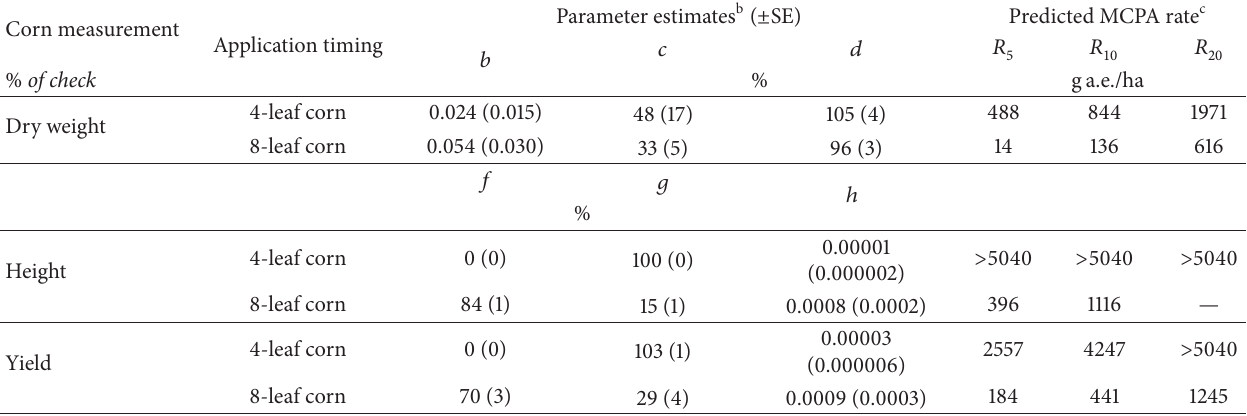
Table 2: Parameter estimates and predicted MCPA rates from regression models of percent maize dry weight (4 WAT), height (8 WAT), and yield a